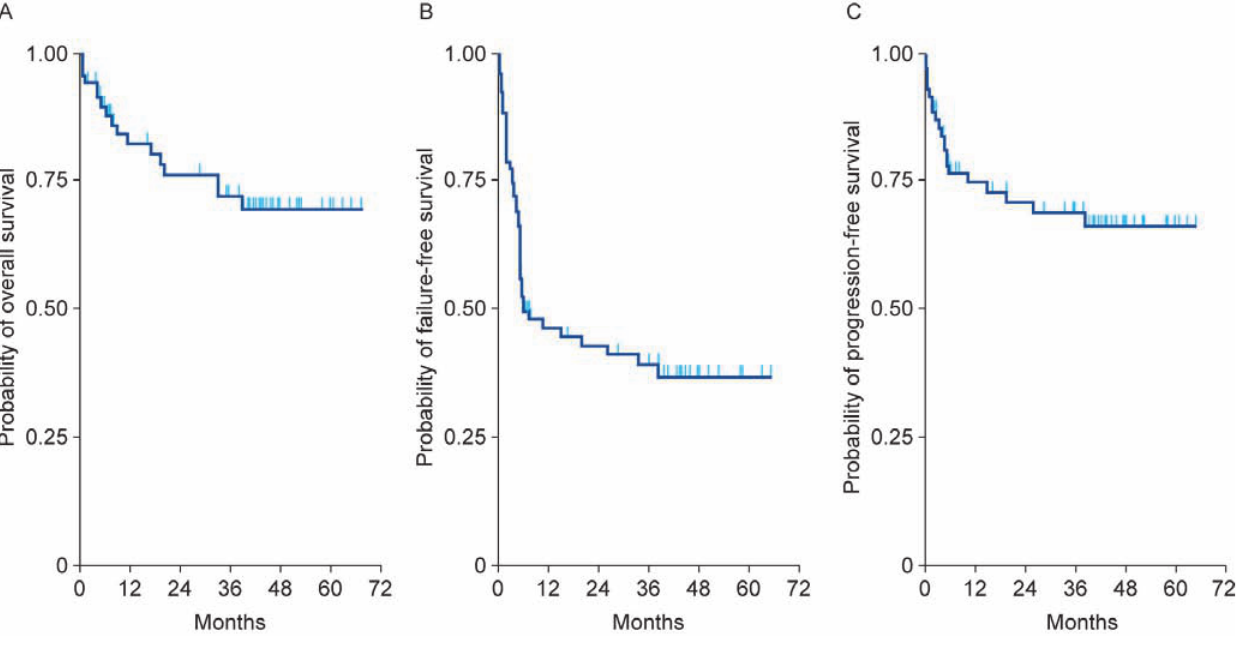
Figure 2. Left ventricular ejec- tion fraction (LVEF) from base- line to end of treatment in elder- ly patients receiving rituximab, cyclophosphamide, non-pegylat- ed liposomal doxorubicin, vin- cristine, and prednisone (R- COMP) chemothe rapy for dif- fuse large B-cell lymphoma (results from the EUR018 trial). 27 From Luminari S et al . Nonpegylated liposomal dox- orubicin (Myocet TM ) combina- tion (R-COMP) chemo therapy in elderly patients with diffuse